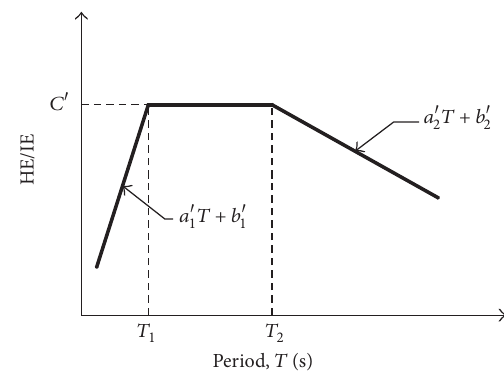
Figure 12: Proposed HE/IE spectra for hysteresis model BS.